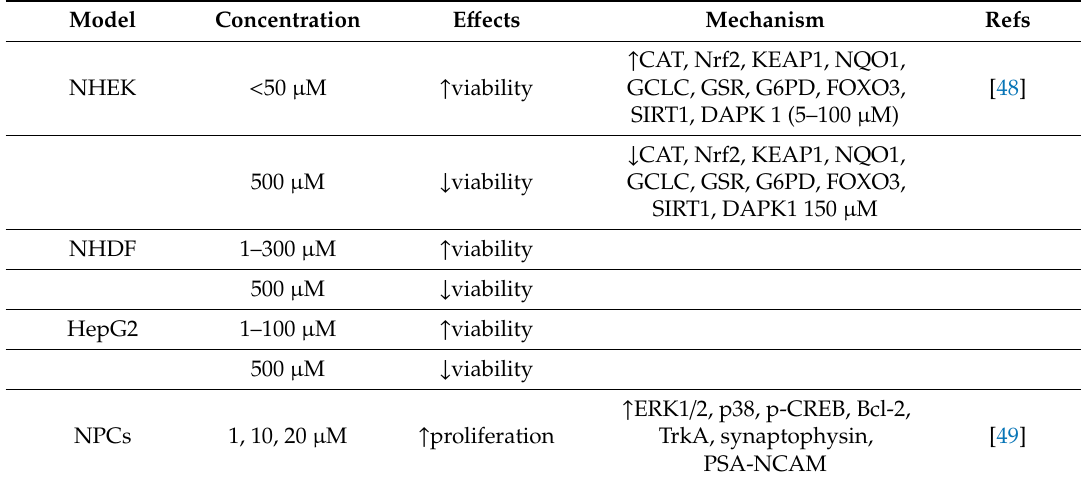
Table 2. Biphasic concentration / dose-response relationship induced by